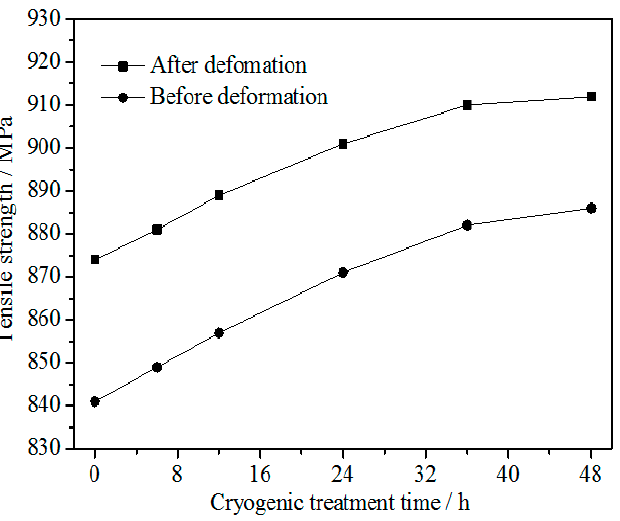
Figure 2. Tensile strength of the Cu-1.34Ni-1.02Co-0.61Si alloy before and after cold rolling at 47% reduction with the DCT time in liquid